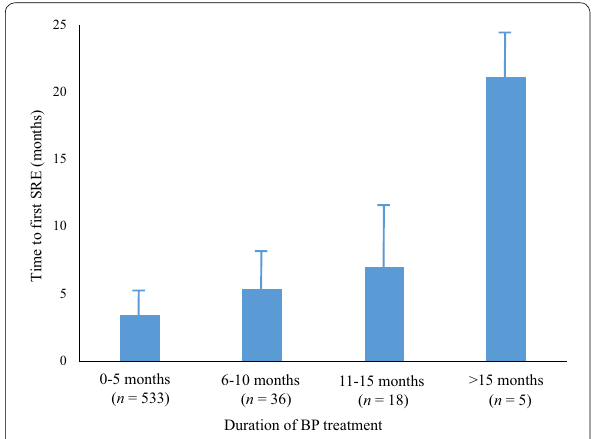
Fig. 2 Relationship between the duration of bisphosphonate (BP) treatment and the time to the first occurrence of SREs. Column , aver- age value; bar , standard